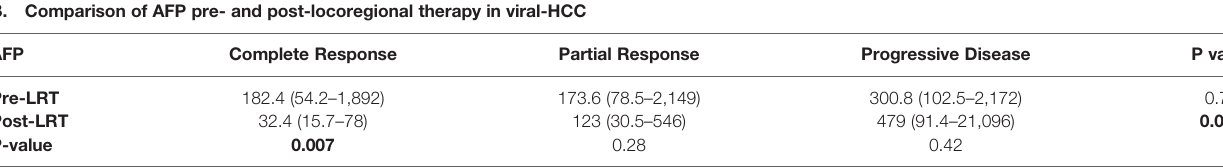
TABLE 5B | Median AFP changes in different categories of response in viral-HCC patients at pre and post LRT. B. Comparison of AFP pre- and post-locoregional therapy in viral-HCC